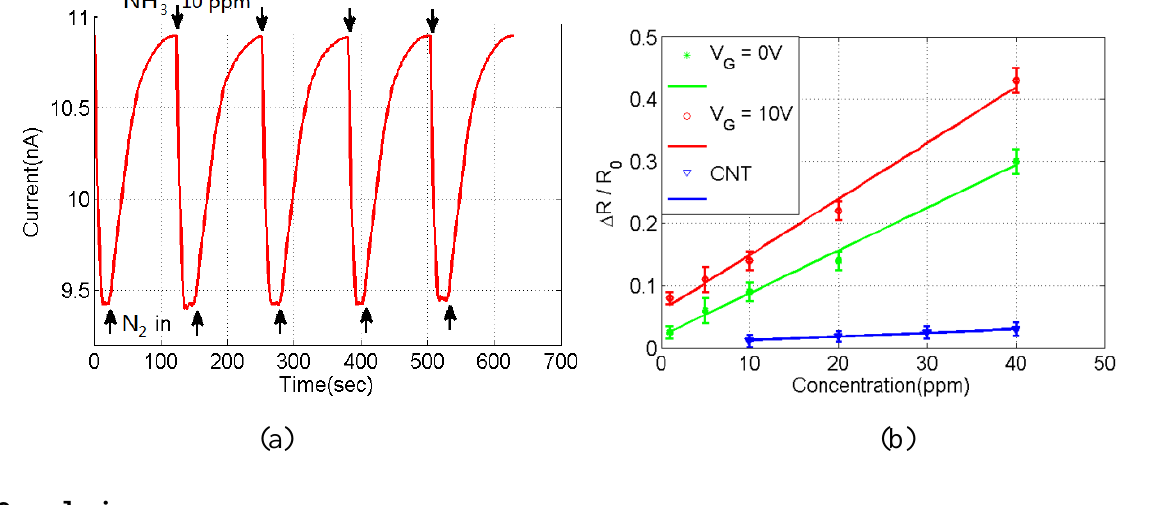
Figure 5. ( a ) Repeatability test with 10 ppm NH Pani fiber sensor with or without gate voltage and CNT